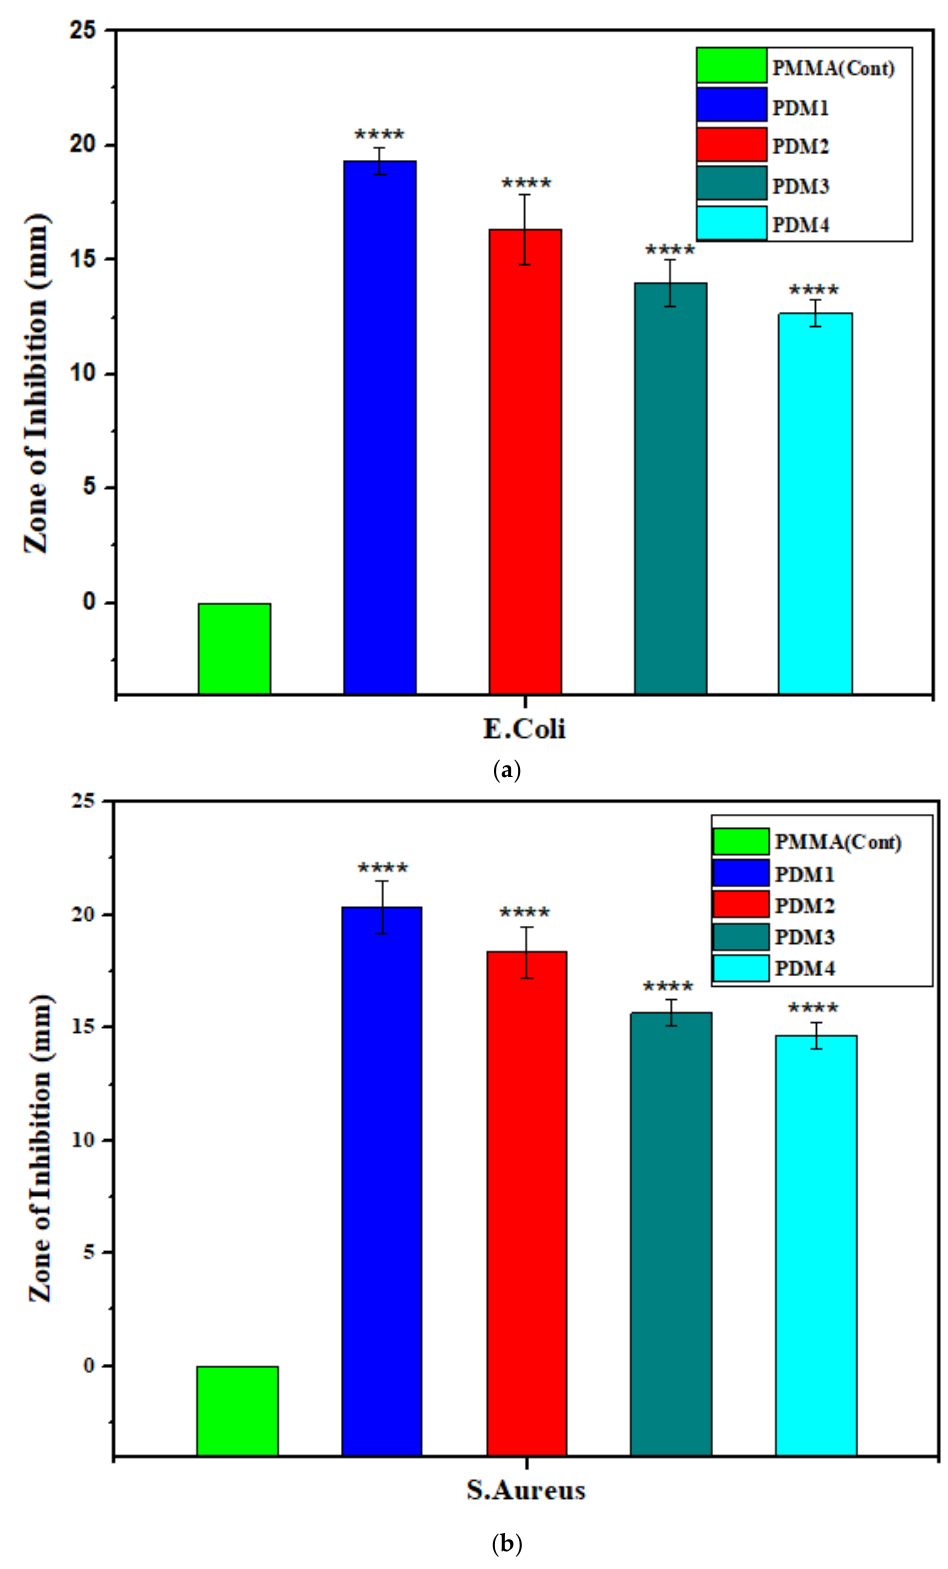
Figure 7. Zone of inhibition of copolymer, PDM1, PDM2, PDM3 and PDM4 with PMMA as a control after t test (**** p < 0.0001): ( a ) against E. coli ; ( b ) against S. aureus.